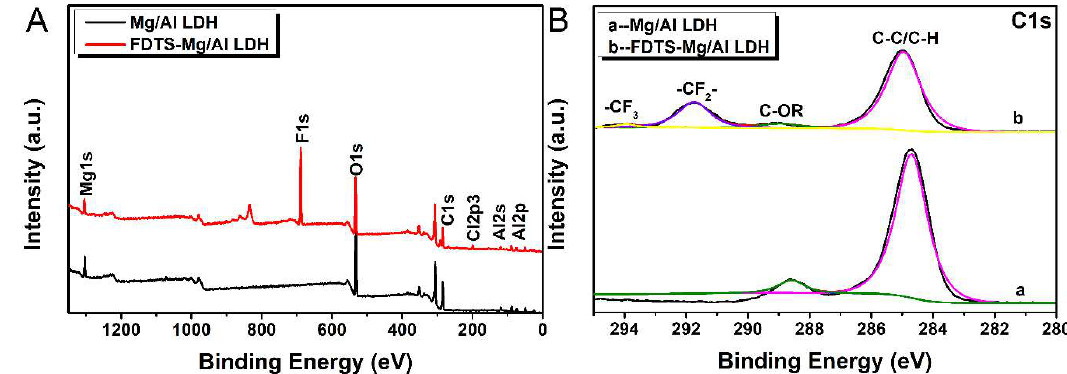
Figure 2. XPS spectra of Mg-Al LDH and FDTS-modified Mg-Al LDH: ( A ) survey spectra; ( B ) C1s.